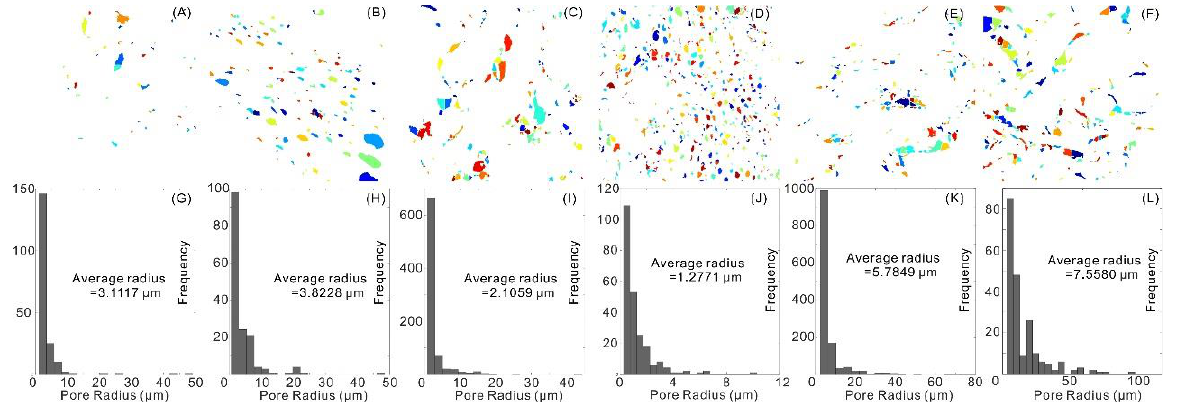
Figure 5. Pore unit segmentation ( A – F ) and pore radius distribution ( G – L ) corresponding to Figure 2A – F.